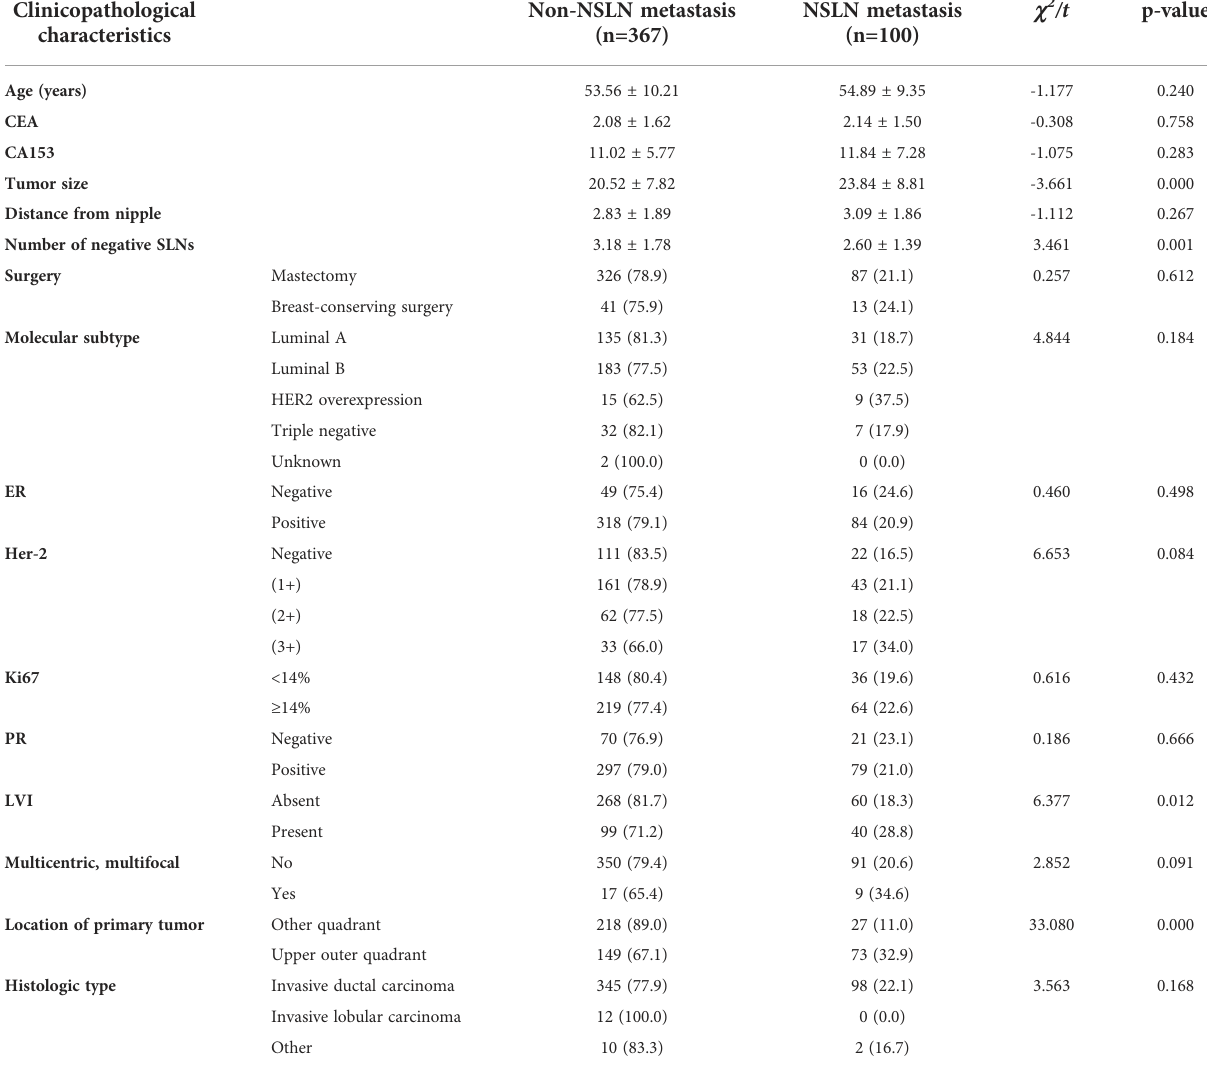
TABLE 2 Univariate analysis of non-sentinel lymph node (NSLN) metastasis based on clinicopathological data in the training cohort. Clinicopathological